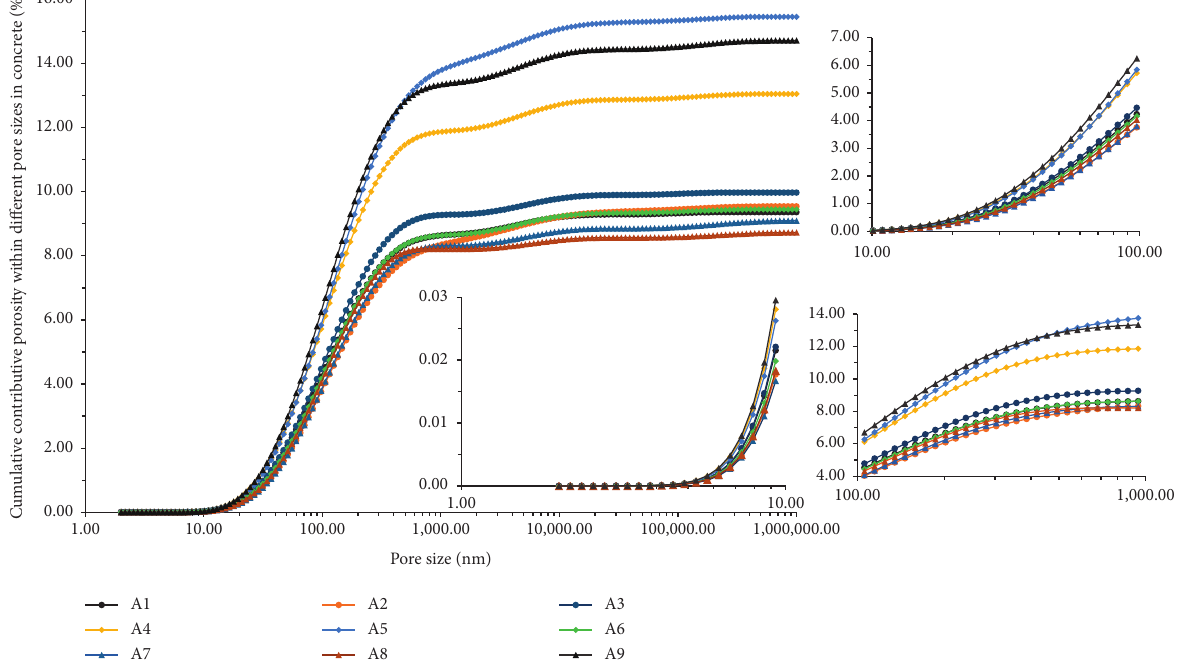
Figure 8: Cumulative contributive porosity within different pore size in Table 7: R 2 of permeability and contributive porosity within different ranges of pore diameter in concrete. < 10nm